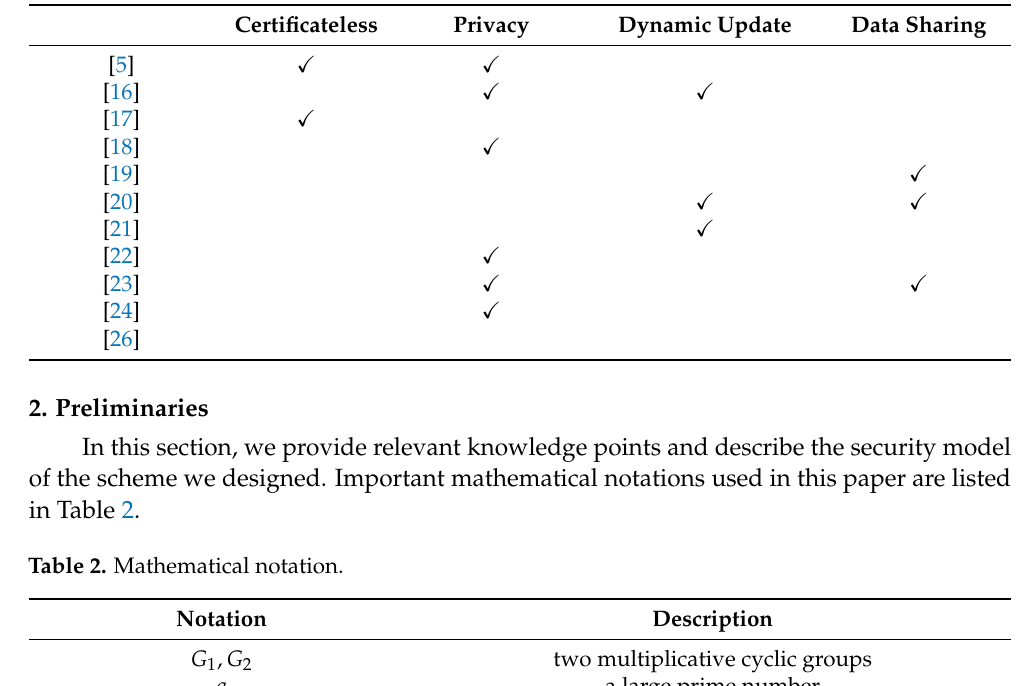
Table 1. Reference scheme comparison table.